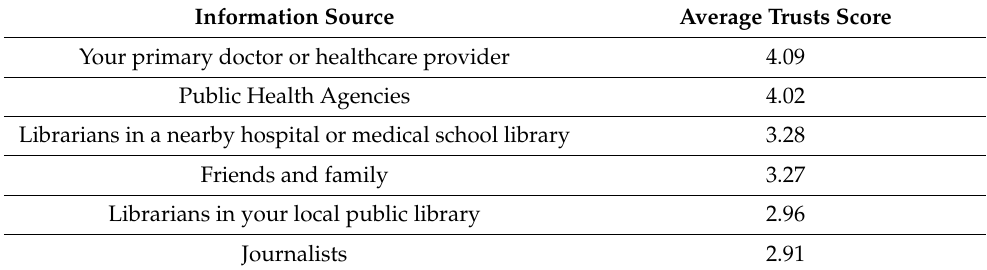
Table 12. Trusted